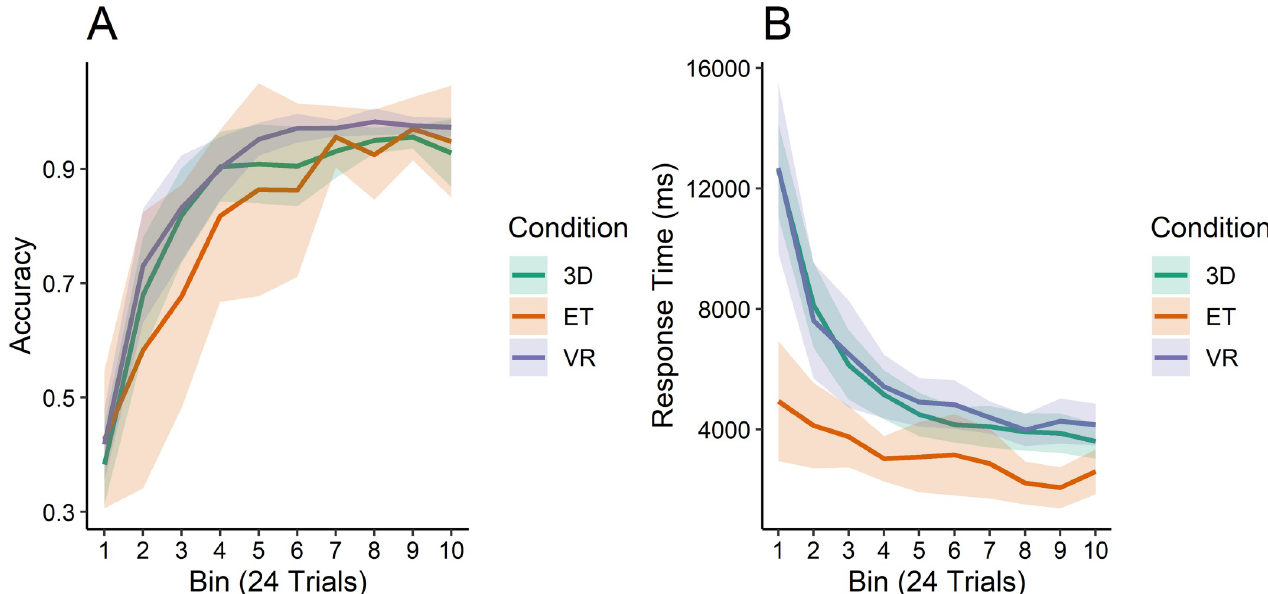
Fig 6. Accuracy and response time results. (A) Accuracy as a proportion and (B) response times across the 10 bins, measured in milliseconds, by condition.